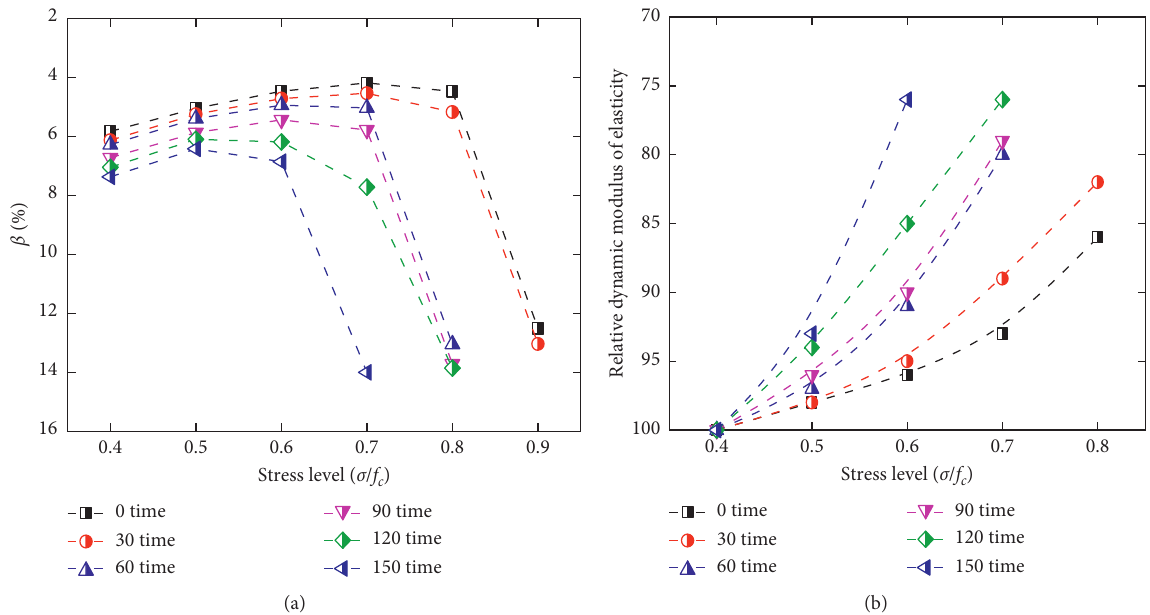
Figure 8: Variations of β (a) with the stress level and the relationship between the stress level and the relative dynamic elastic modulus (b). (a) β and stress level. (b) Stress level and relative dynamic elastic modulus.